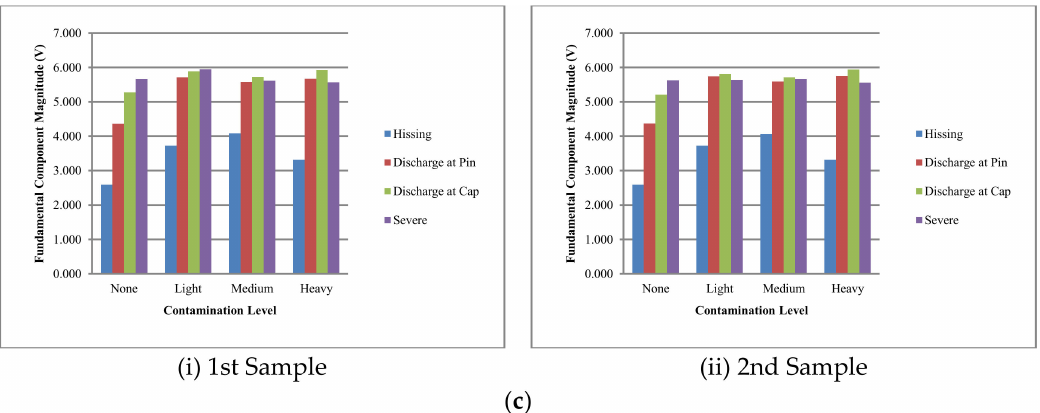
Figure 16. Fundamental frequency components for dry condition for samples: ( a ) Group A; ( b ) Group B; ( c ) Group C insulators.